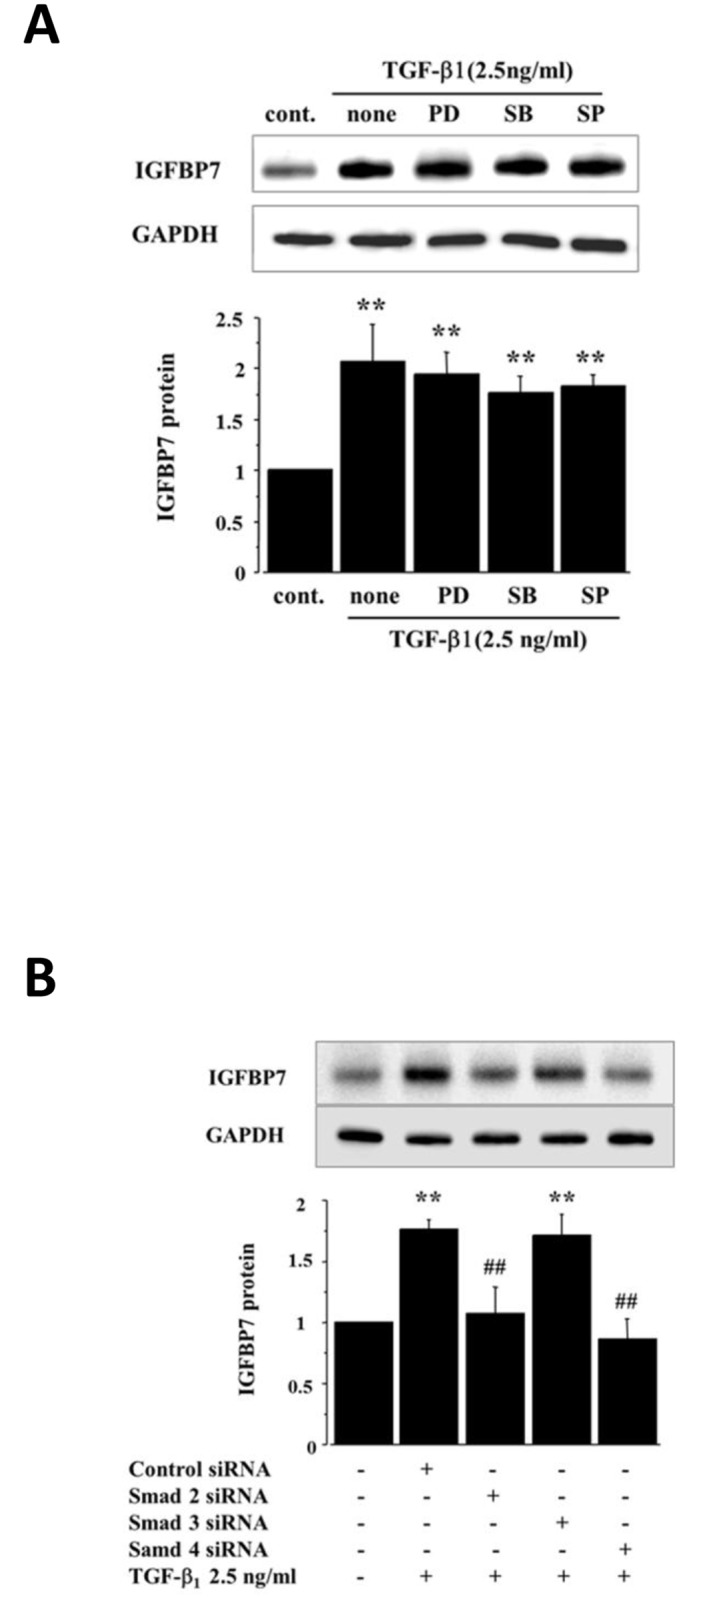
IGFBP7 enhancement by TGF-β1 is dependent on Smad pathways.(A) The effects of pretreatment of HRPTECs for 1 h with the Erk1/Erk2 inhibitor PD98059 (PD, 10 μM), the p38 MAPK inhibitor SB203580 (SB, 10 μM), or the JNK inhibitor SP600125 (SP, 10 μM), followed by the administration of TGF-β1 (2.5 ng/ml) for 48 h on the expression of IGFBP7 protein. “None” indicates no administration of the kinase inhibitor. These MAPK inhibitors did not affect the TGF-β1-induced IGFBP7 expression. (B) HRPTECs were transiently transfected with control, Smad2-, Smad3-, or Smad4-specific siRNAs (25 nM final concentration). Forty-eight hours after transfection, the HRPTECs were serum-starved for an additional 24 h and then stimulated with TGF-β1 (2.5 ng/ml) for 48 h, and a western blot analysis for IGFBP7 protein was performed. Lowering the expressions of Smad2 and Smad4 proteins reduced the TGF-β1-induced IGFBP7 expression. **p<0.01 vs. control, ##p<0.01 vs. TGF-β1-treated HRPTECs.